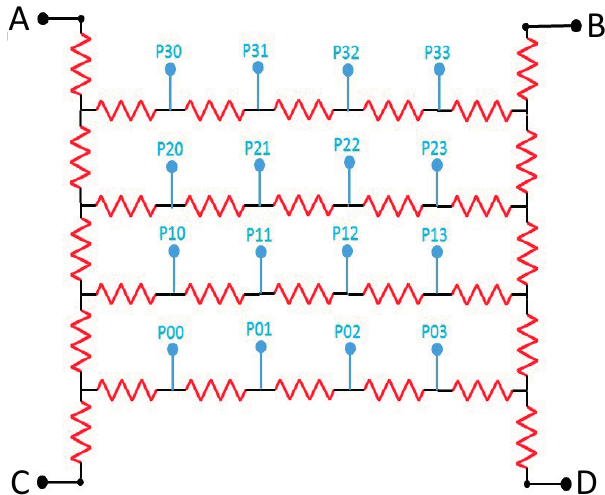
Figure 1. Simplified circuit of the 16:4 resistor network used to reduce the number of outputs from a 4 × 4 array of SiPMs to four outputs labeled A , B , C and D .